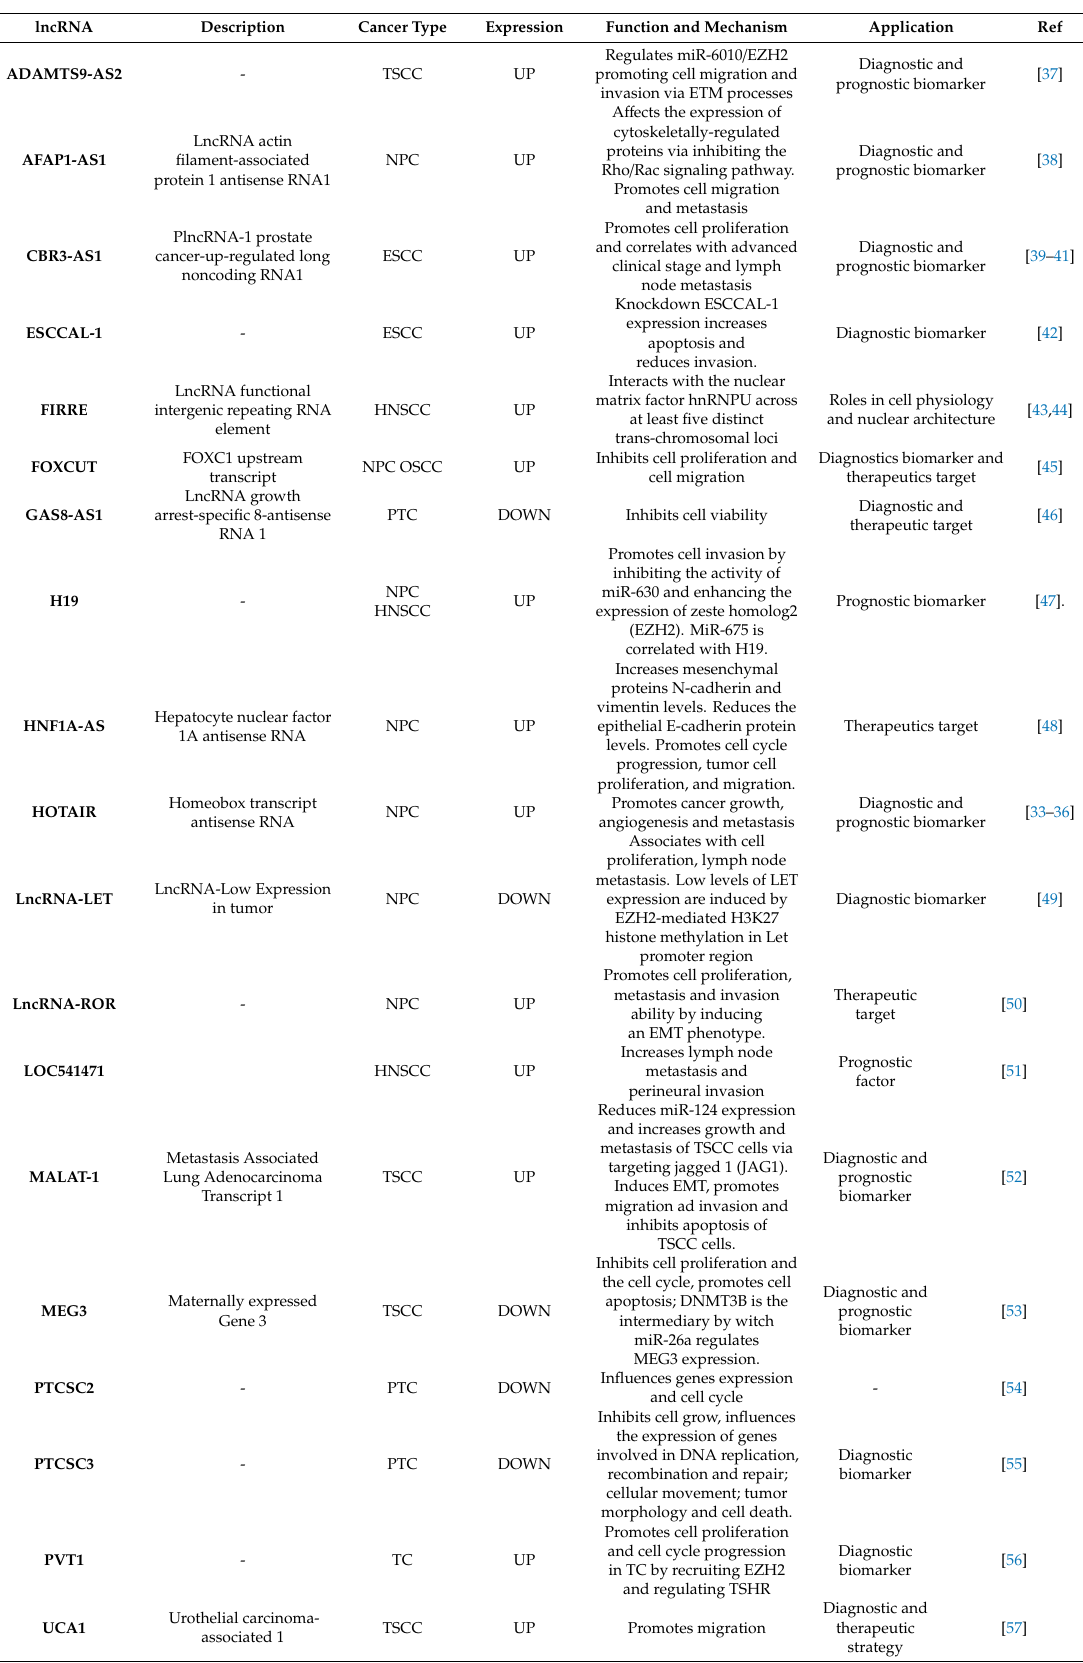
Table 1. LncRNAs in